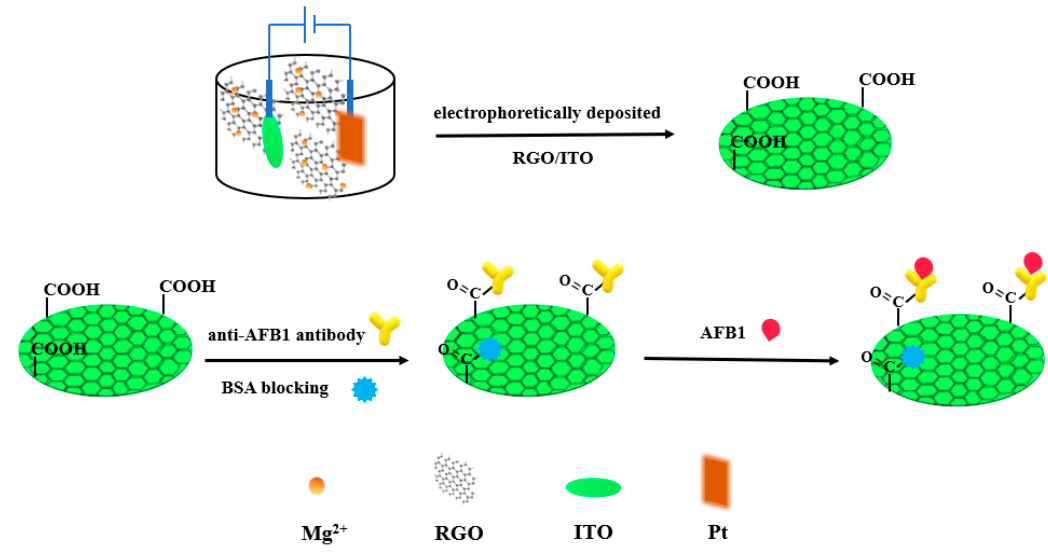
Figure 3. Scheme of electrophoretically deposited rGO platform for AFB1 detection.